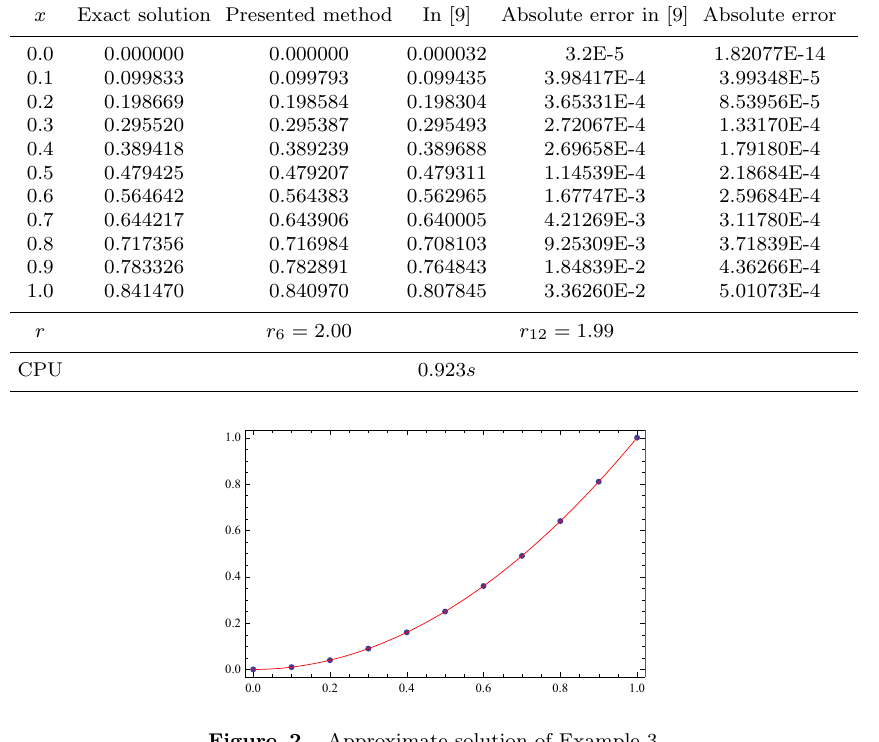
Table 3. Numerical result and absolute error for Example 3. x Exact sol. Presented method In [4] Abs. error in [4] Abs. error